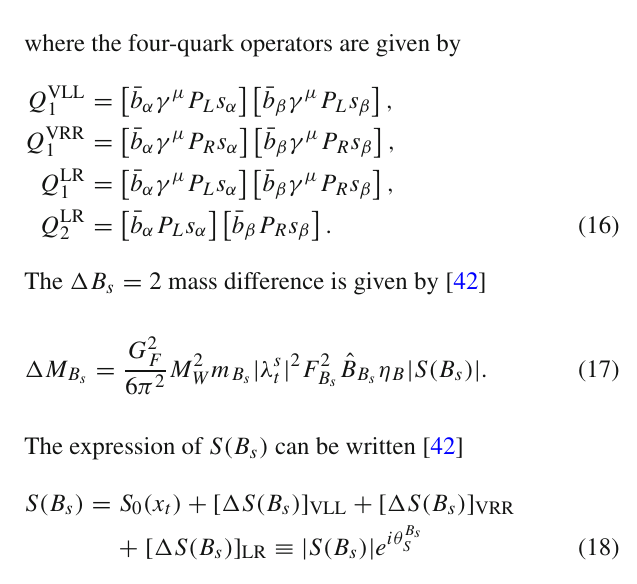
and errors due to SCET parameters respectively. For a comparison with previous studies in the literature, we list the results evaluated in